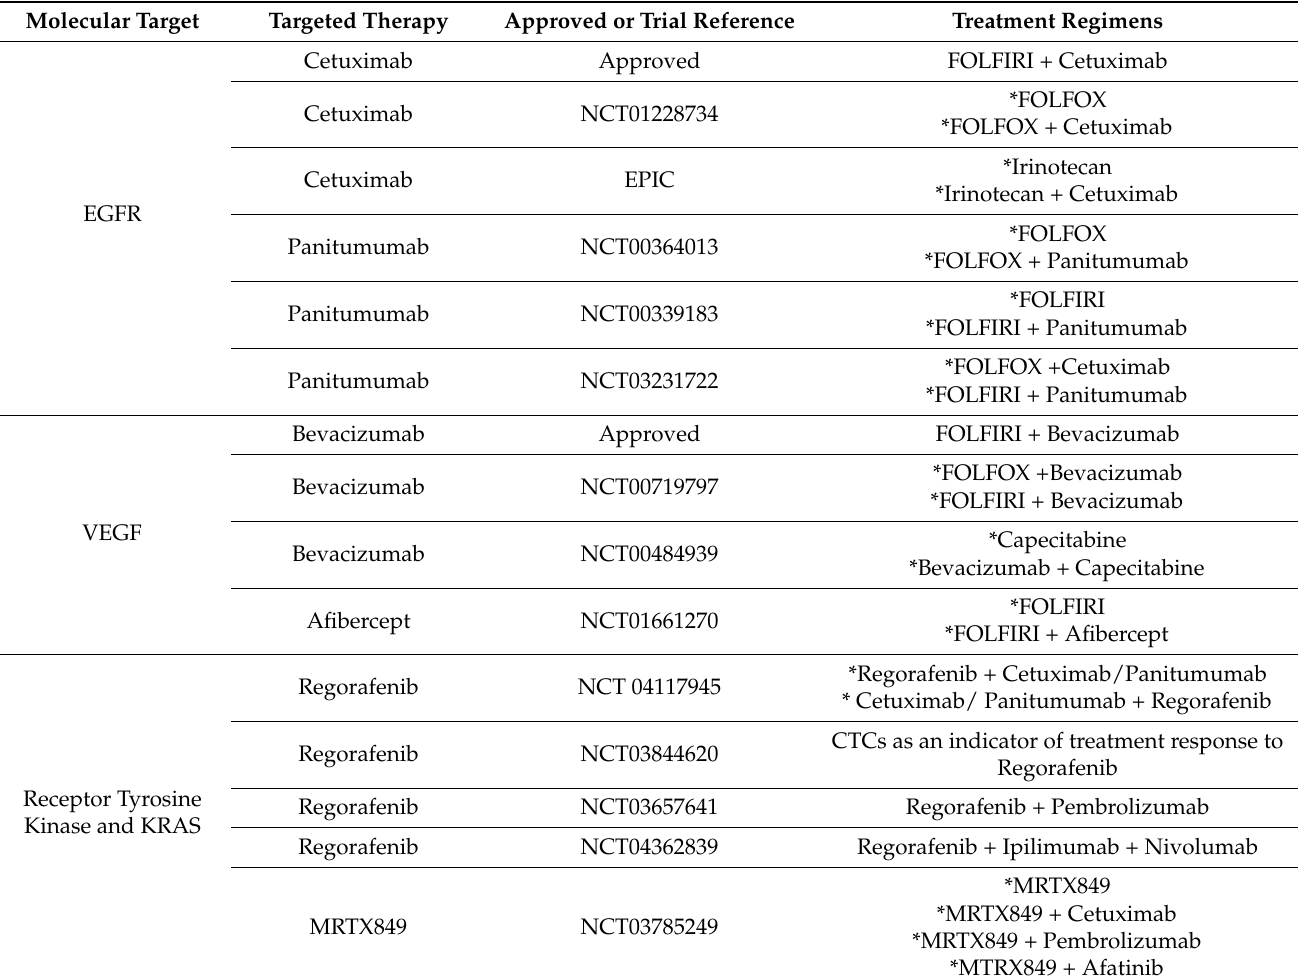
Table 2. Targeted treatment regimens for